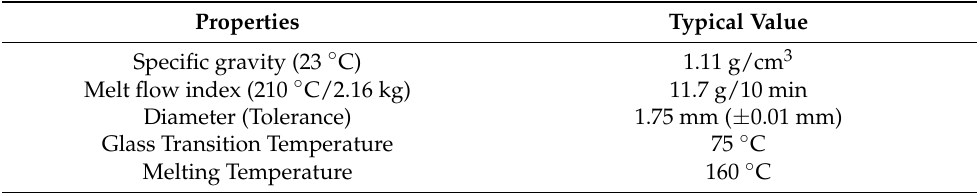
Table 1. Characteristics of graphene-enhanced PLA